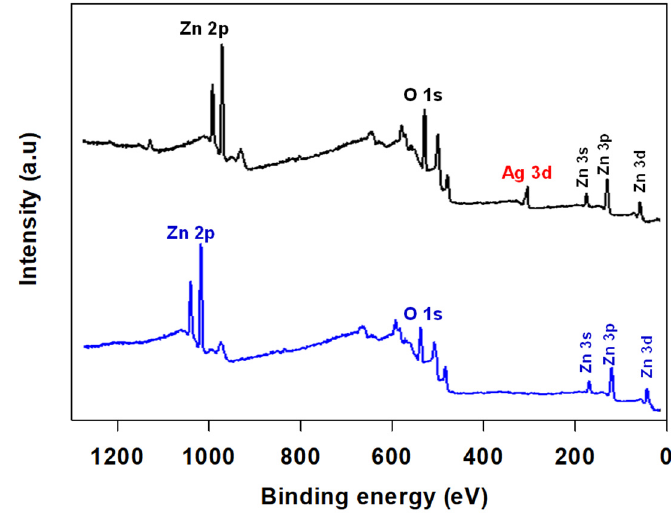
Figure 3. XPS survey of ZnO (blue) and Ag-ZnO (black).